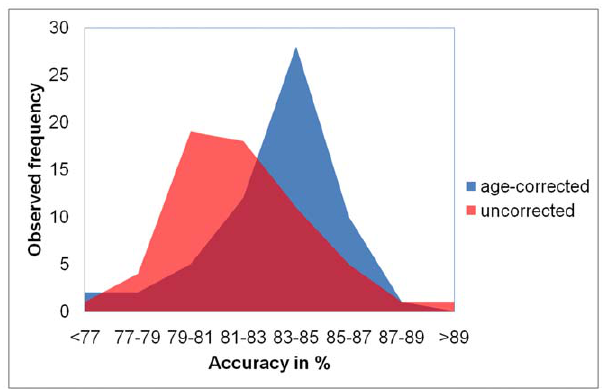
Figure 2. Results of permutation statistics using SVM. Results of permutation statistics using SVM split half cross-validation on uncorrected (red) and age-corrected data (blue). Observed frequency is the cumulative number of accuracies observed for a specific accuracy range.